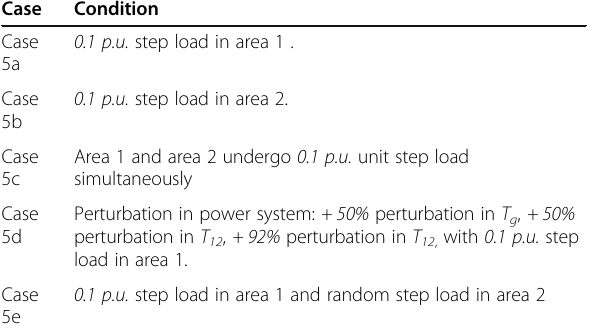
Table 4 The conditions for test cases for case study 5